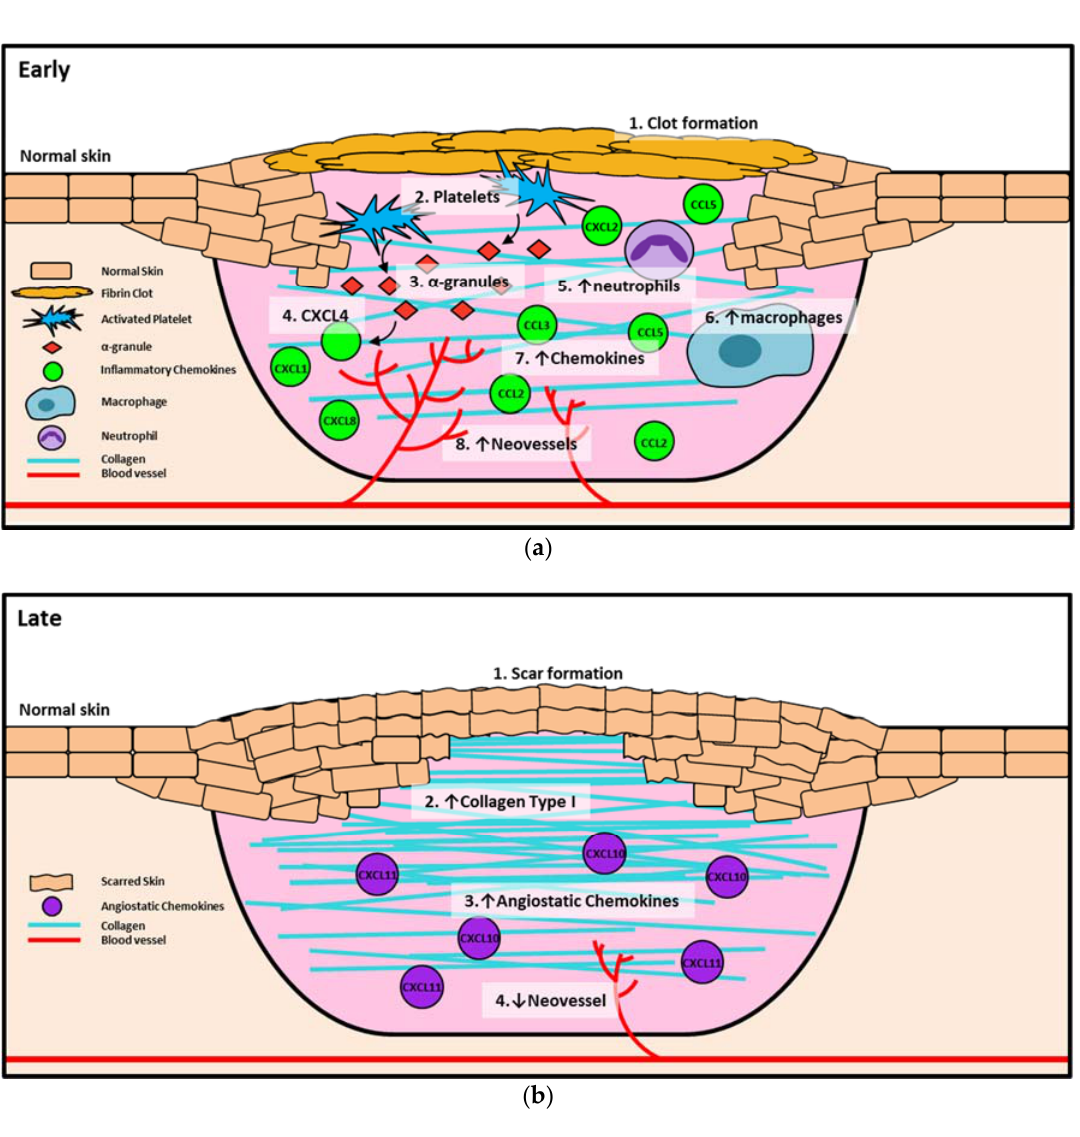
Figure 1. Chemokines in early and late phases of wound healing. ( a ) Early wound healing, including clot formation, inflammation, and proliferation. (1) Clot formation occurs to prevent the loss of blood and (2) platelets are activated and release (3) α -granules, which in turn release (4) CXCL4 as an early inhibitor of angiogenesis. Once the clot has fully formed other, chemokines such as CXCL8, CXCL1, and CXCL2 are released by α -granules to recruit inflammatory cells, including (5) neutrophils and (6) macrophages. Neutrophils are increased early in the healing process, then macrophages soon take over as the primary inflammatory cell. Neutrophils and macrophages release (7) chemokines such as CCL2, CCL3, and CCL5 into the wound to promote the recruitment of more inflammatory cells that release pro-angiogenic growth factors that (8) increase neovessel formation in the wound. ( b ) Late wound healing is the remodeling stage. In this stage, the wound is fully healed and (1) a scar has formed. Type 3 collagen converts to (2) type 1 collagen to promote scar formation and create a more stable wound seal. During the remodeling process (3), angiostatic chemokines (CXCL10, CXCL11) promote the (4) regression of neovessels, as there is no longer a requirement for enhanced blood flow or the recruitment of immunological cells to the site. ↓ : indicates decrease; ↑ : indicates decrease.